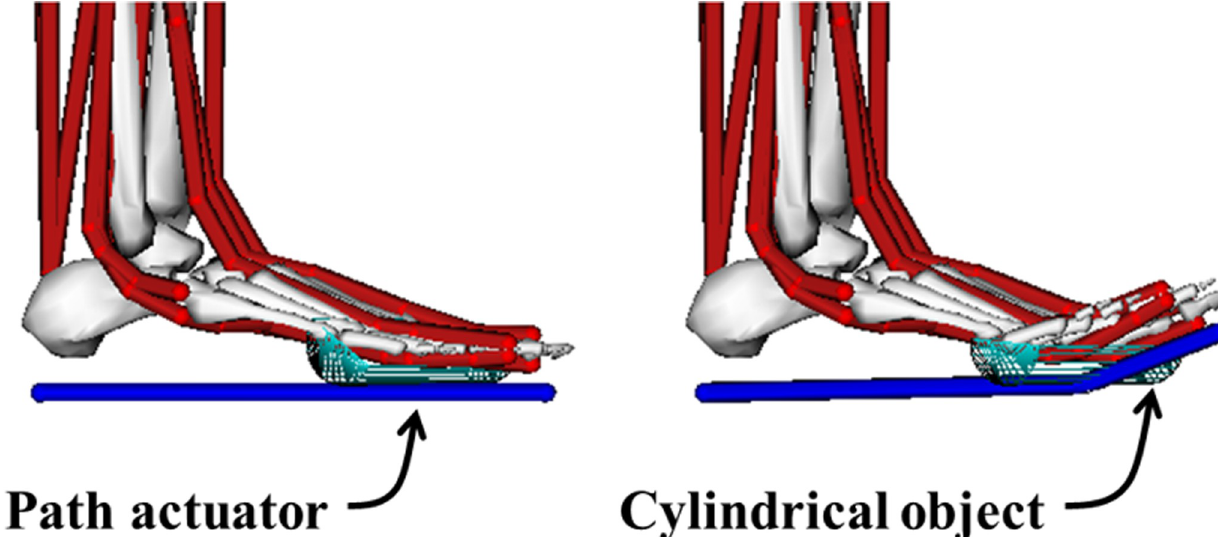
Fig 3. Foot segments of a musculoskeletal model. A path actuator and cylindrical object added to the foot segments of a musculoskeletal model.